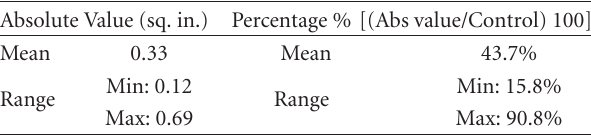
Table 3: Computer-assisted navigation